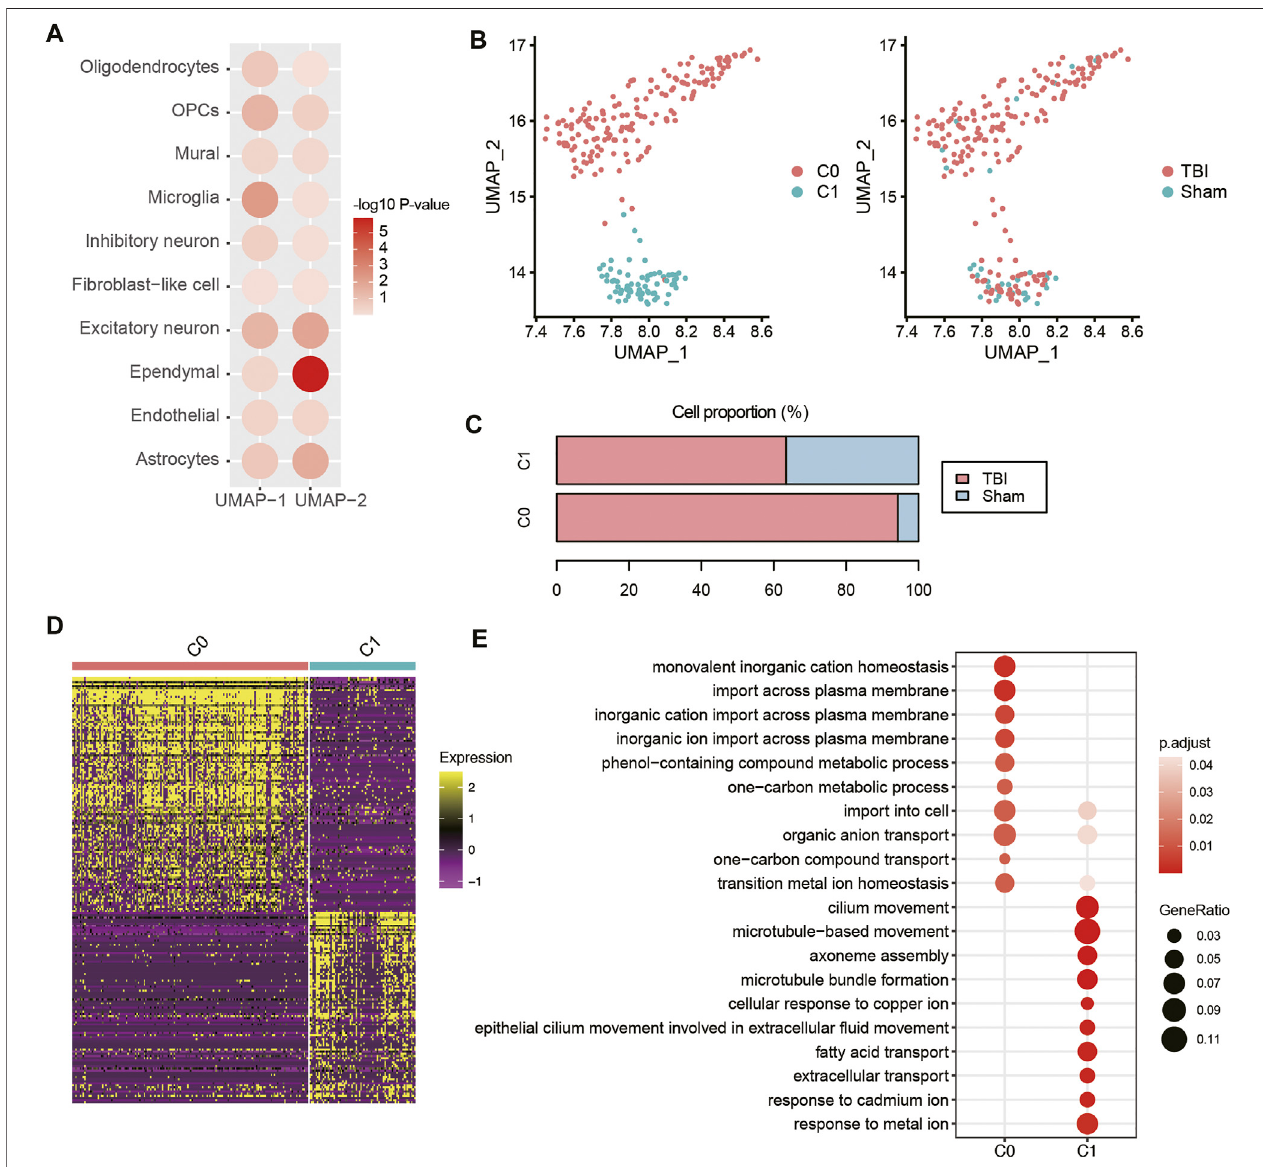
FIGURE 5 | The transcriptional changes of ependymal cells of TBI. (A) The differential distribution of the top-two UMAP components (UMAP-1 and UMAP-2) betweenTBIandSham.TheWilcoxonranksumtestwasapplied. (B) Thesub-clusteringofependymalcells. (C) TheproportionofependymalcellpopulationsinTBIand Sham samples. (D) The differential expression patterns of marker genes between the two ependymal cell subpopulations. (E) The pathways enriched by the marker genes of the two ependymal cell subpopulations.